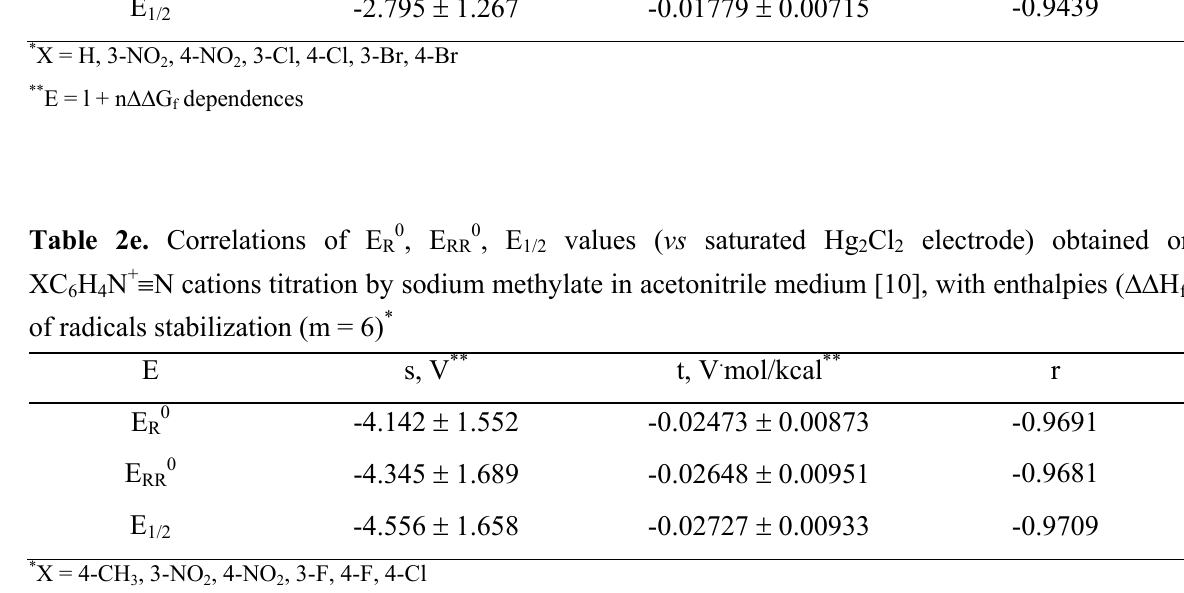
Cl electrode) obtained 2 2